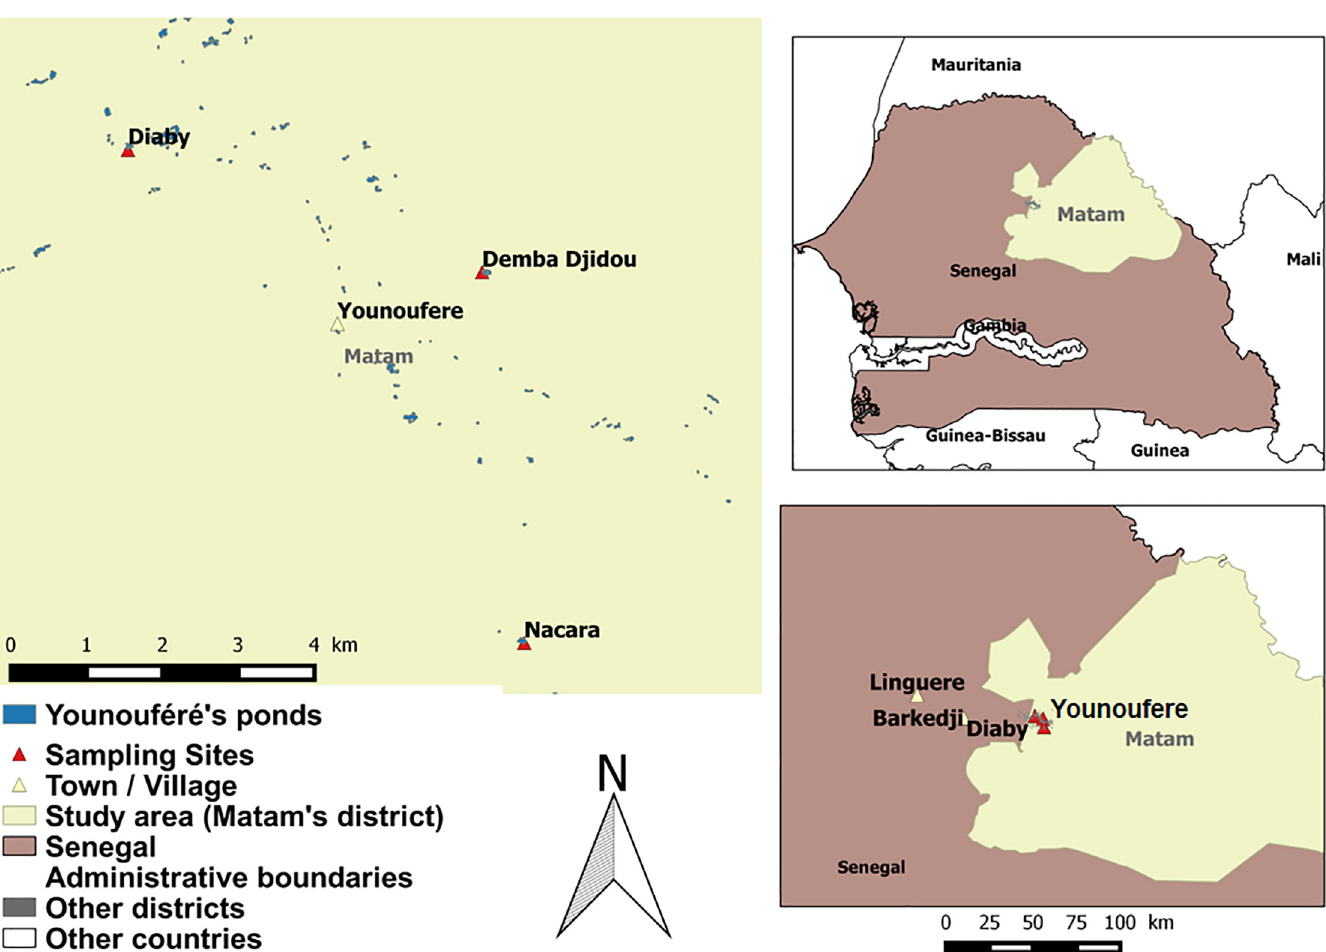
Fig 1. Location of the three sampling sites in Ferlo pastoral ecosystem (northern Senegal). Top-right corner figure: Senegal map and area of interest (Matam). Bottom-right corner figure: red triangles correspond to the three sampling sites, while the other ones represent main towns/villages near the sampling sites. Main figure: detail of the locations of the three sampling sites in